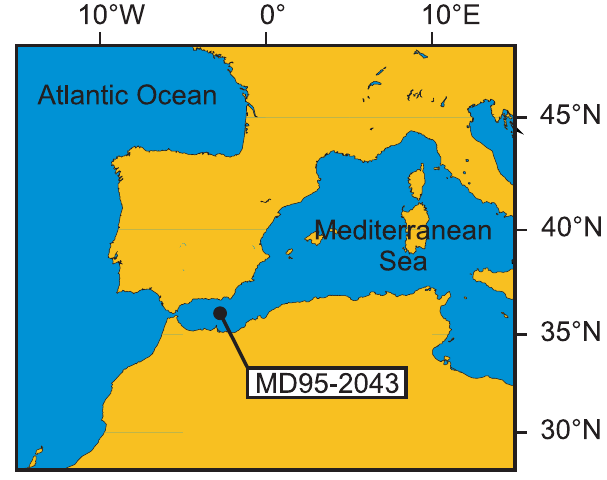
Fig. 1. Location of core MD95-2043 in the Western Mediterranean